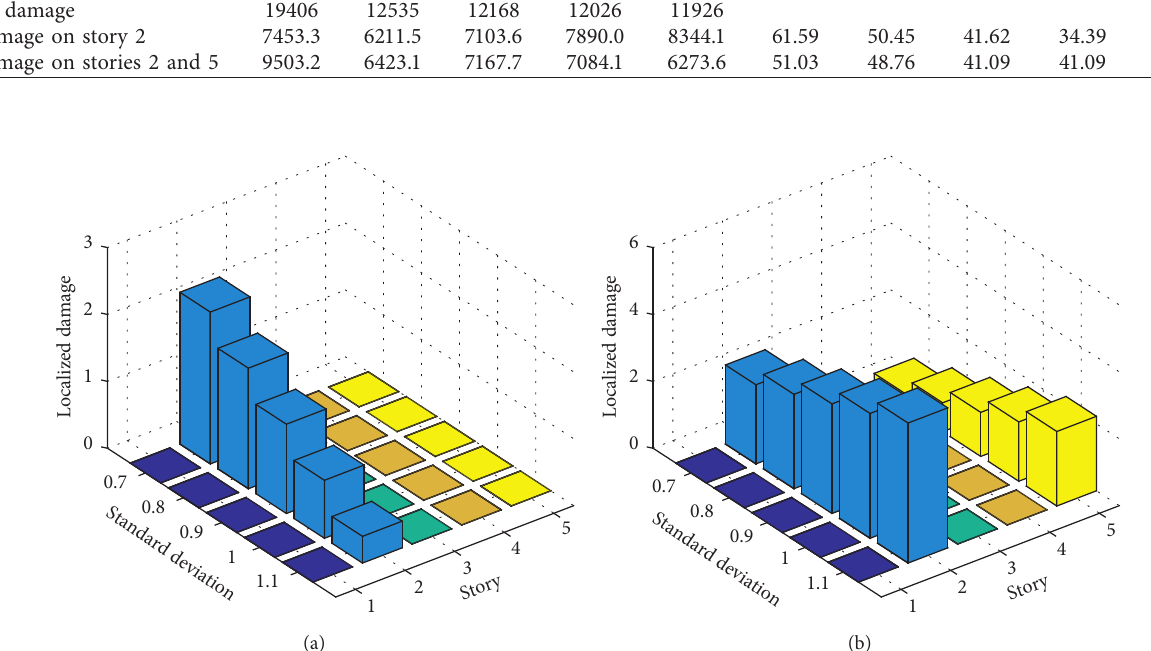
Figure 9: Location and evaluation of structural damage from the damage building. (a) Threshold sensibility analysis, localized damage on story 2. (b) Threshold sensibility analysis, localized damage on stories 2 and